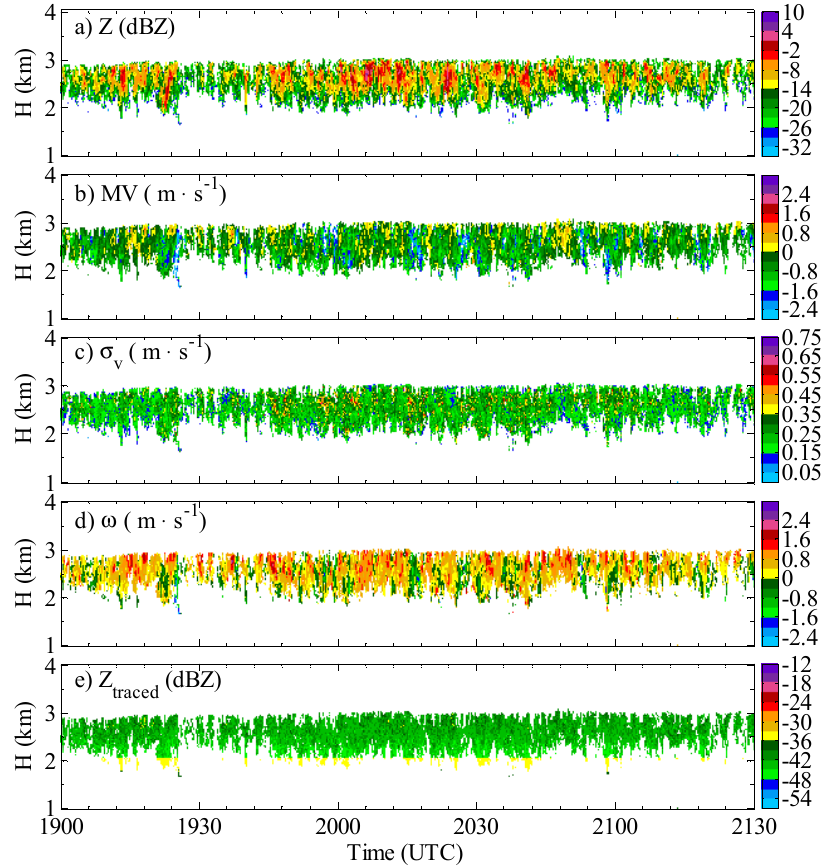
Figure 6. Cloud radar measurements and retrieval results of a series of fair-weather shallow cumuli collected from 19:00 to 21:30 UTC on 16 July 2015; ( a ) is the reflectivity; ( b ) is the mean Doppler velocity; ( c ) is the spectrum width; ( d ) is the vertical air velocity; ( e ) is the reflectivity of traced spectral bin.